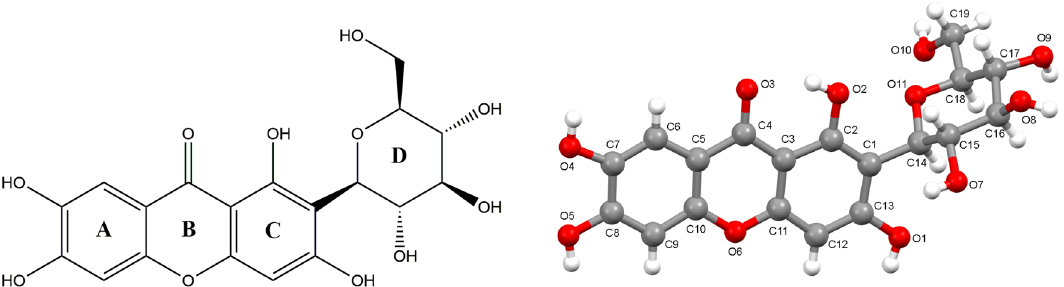
Fig. 1 Molecular structure and numbering of